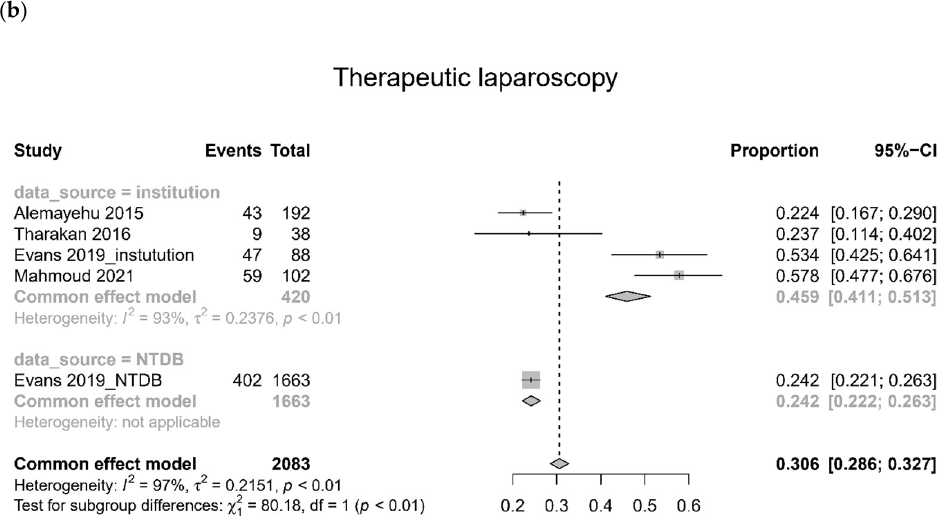
Figure 5. Quality of laparoscopic procedure. ( a ) missed injury, ( b ) avoidance of laparotomy, and ( c ) therapeutic laparoscopy.